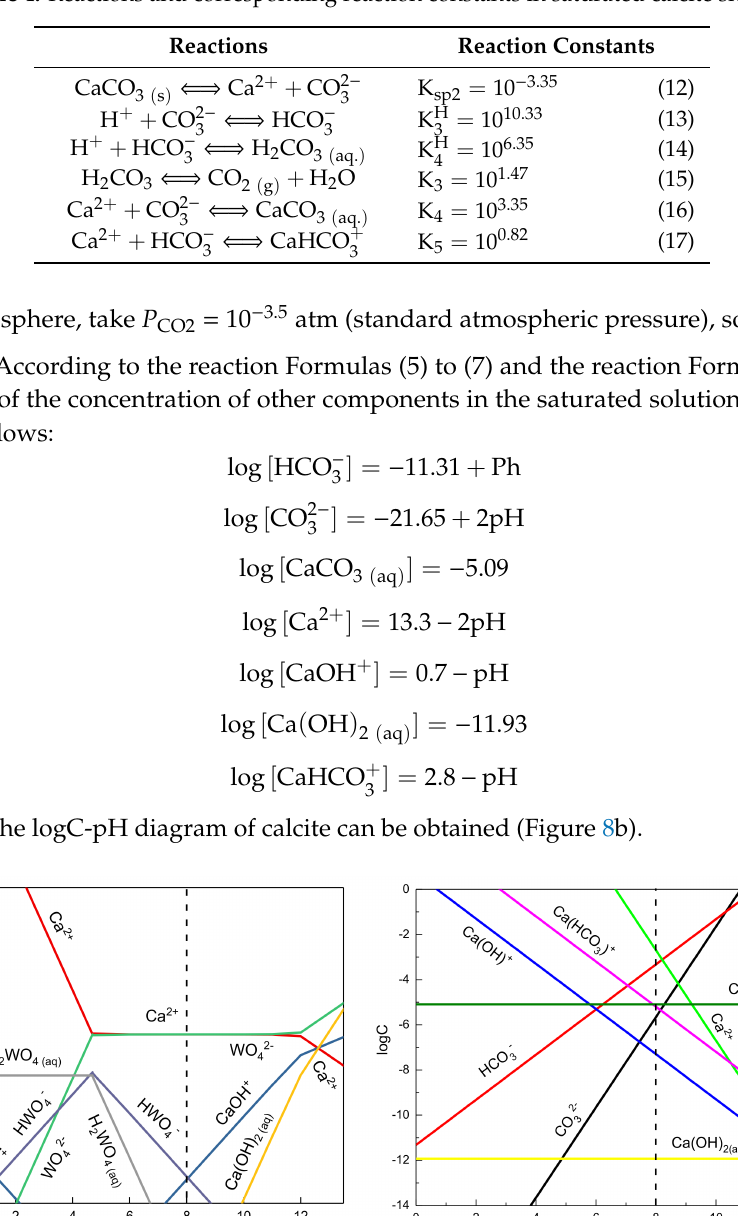
Table 4. Reactions and corresponding reaction constants in saturated calcite slurry.